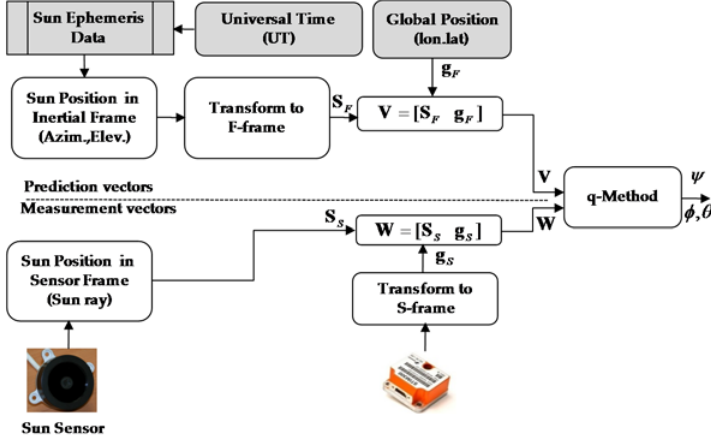
Figure 5. Optimization based attitude estimation ( q ‐ Method ) algorithm block diagram.